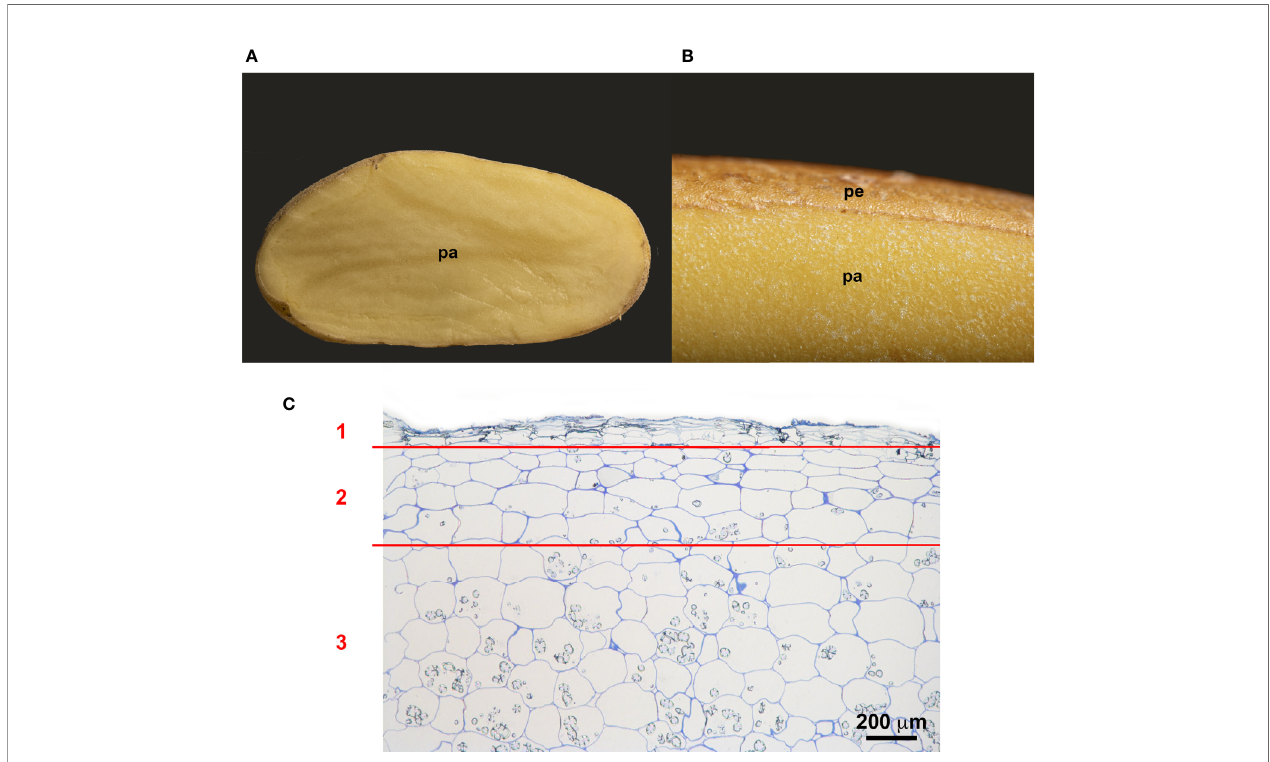
FIGURE 2 | Structure of the potato periderm. (A) Longitudinal section of a potato tuber. (B) Close view of the potato periderm (pe) and parenchyma (pa). (C) Microscopic semithin section of the suberized phellem (1), the starch-depleted phelloderm (2) and the starch-containing storage parenchymal cells (3). Bar corresponds to 200